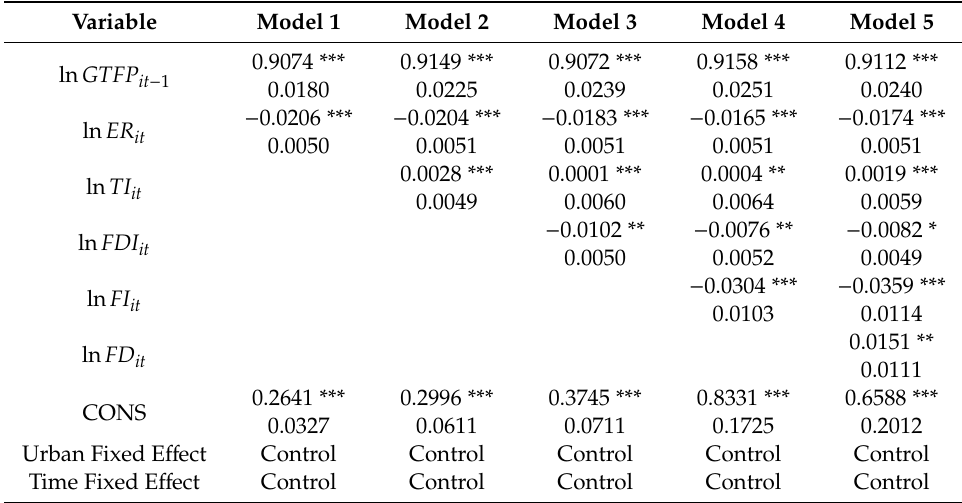
Table 4. Full sample regression results (dependent variable: